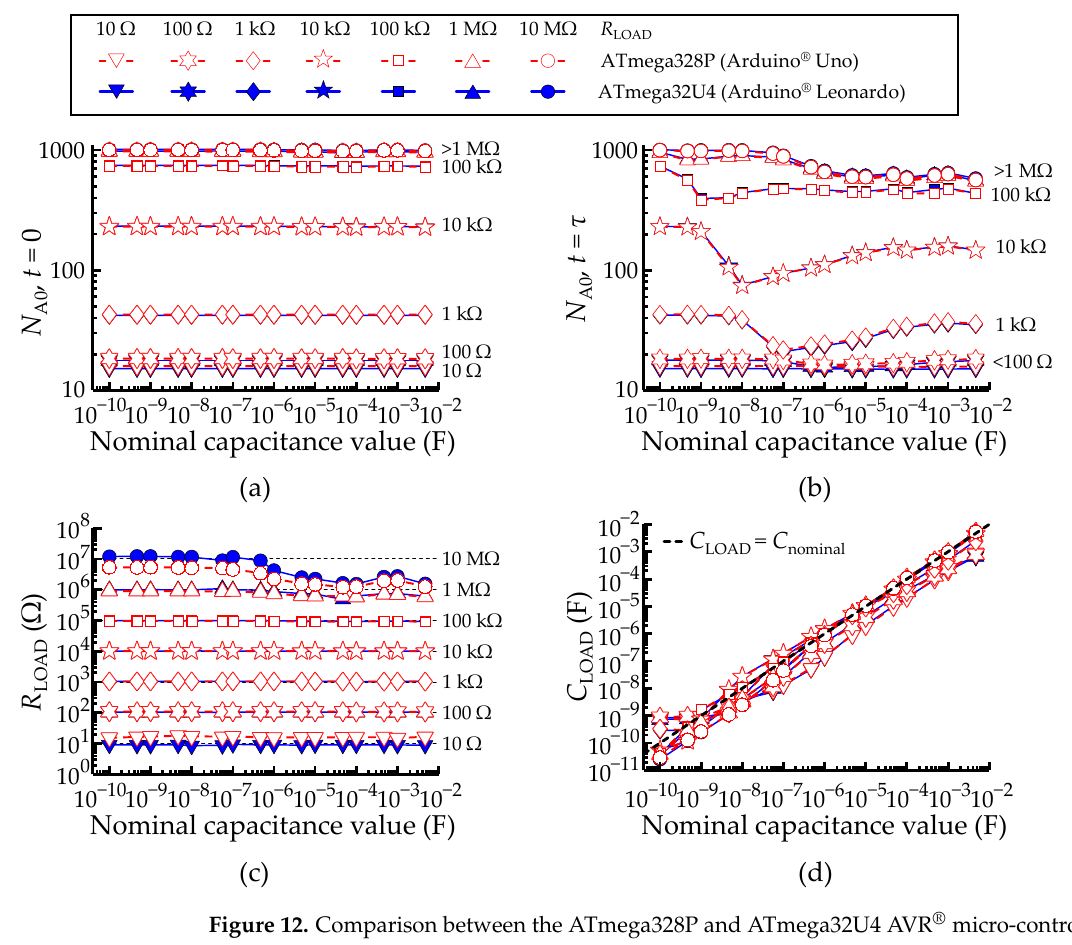
Figure 12. Comparison between the ATmega328P and ATmega32U4 AVR ® micro-controllers configured to measure a parallel RC network. ( a ) Measured ADC value at t = 5 τ . ( b ) Measured ADC value at t = τ . ( c , d ) Obtained R LOAD and C LOAD values according to Equations (2) and (12), respectively. A legend to describe the color scheme used in all plots of Figure 12 was included. The black dashed lines always represent the theoretical lines.